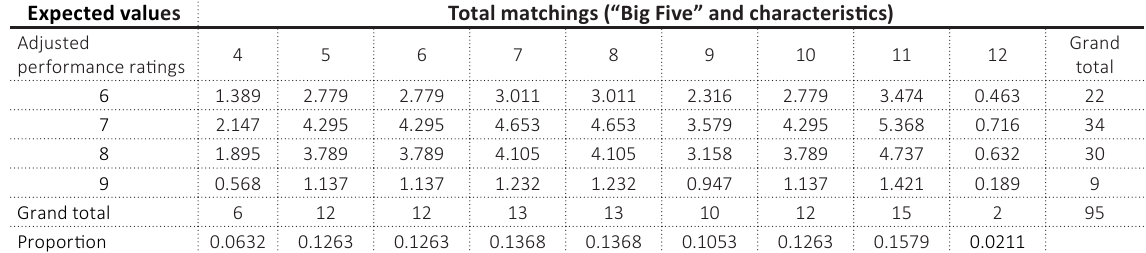
Source: Field survey.